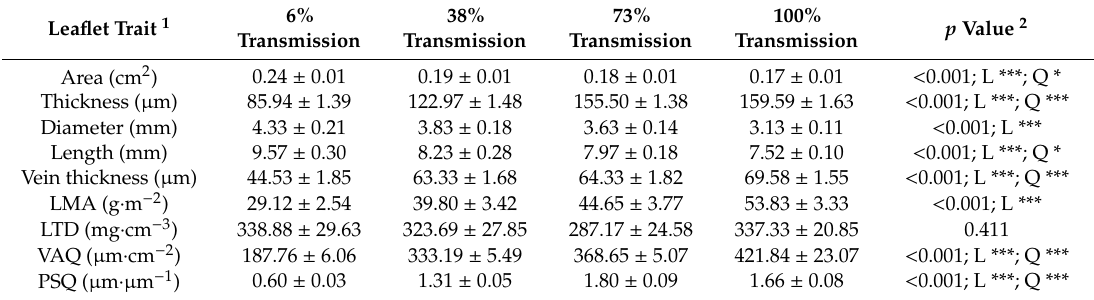
Table 3. Serianthes nelsonii leaflet traits as influenced by percent sunlight transmission during leaf growth. Mean ± standard error.